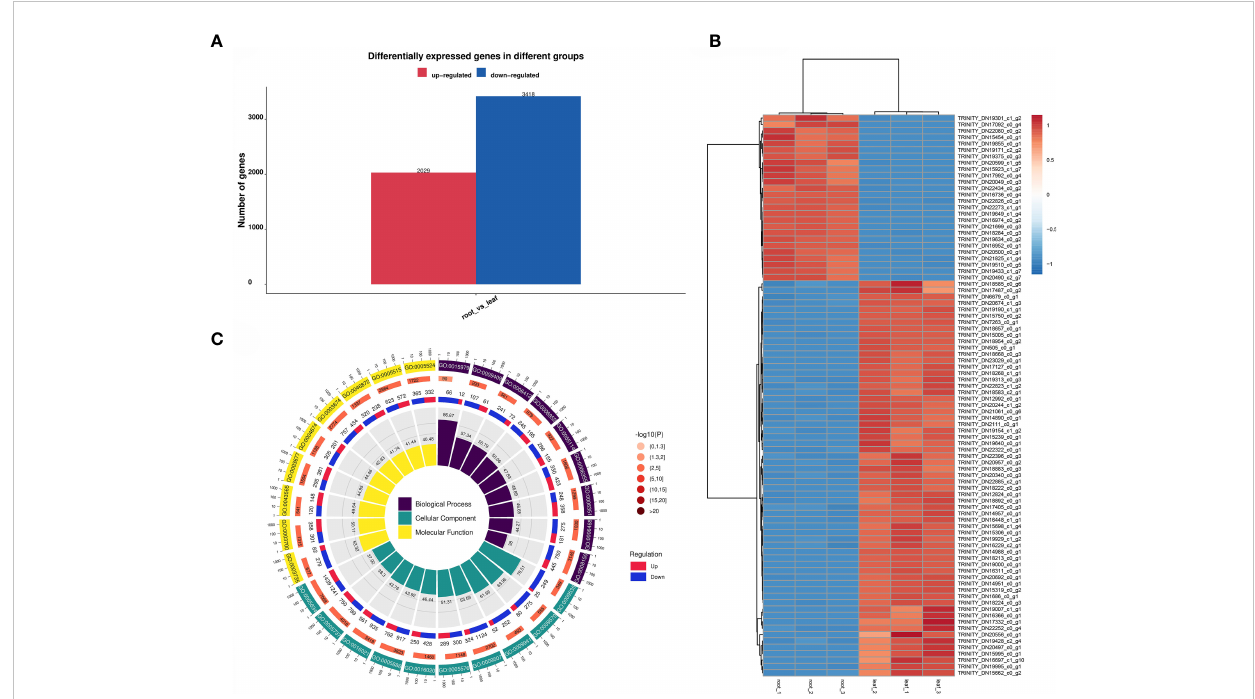
FIGURE 5 Functional analysis of differentially expressed genes. (A) : DEGs in the roots and leaves of S. divaricata. (B) : Cluster heatmap of differentially expressed genes in root and leaf of S. divaricata. (C) : Go mapping of differentially expressed genes in root and leaf of S. divaricata